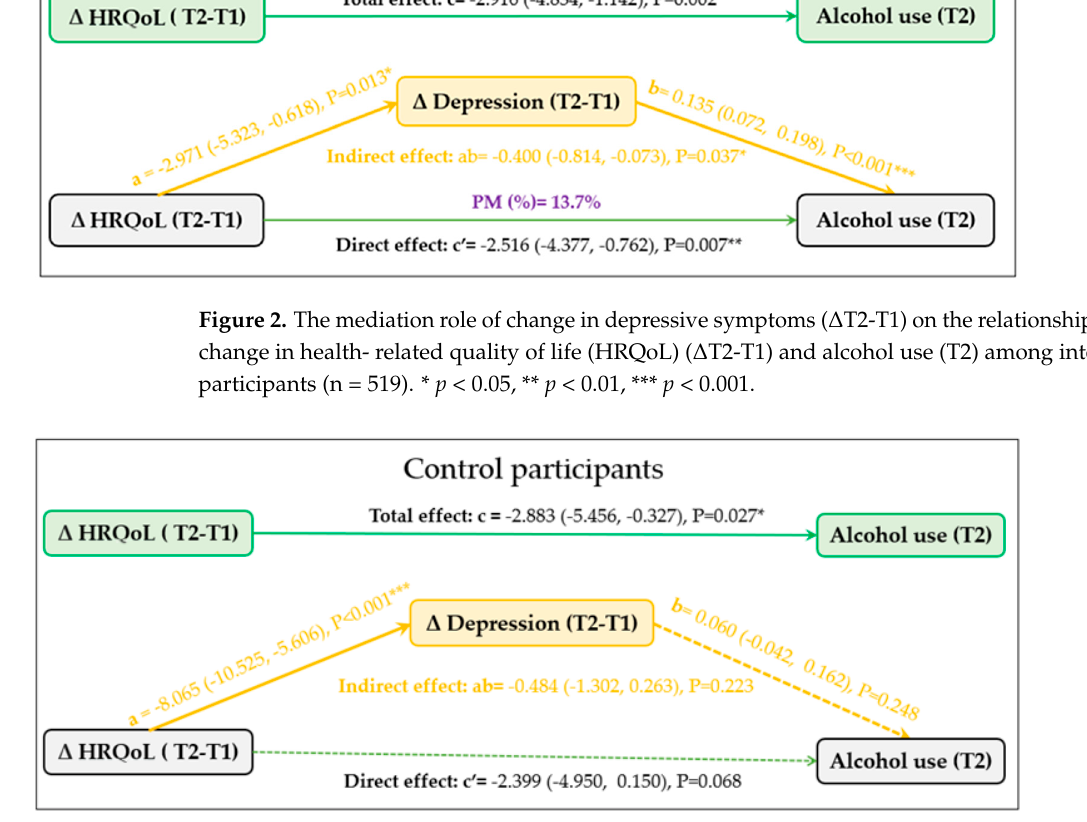
Figure 3. The mediation role of change in depressive symptoms ( ∆ T2-T1) on the relationship between change in health- related quality of life (HRQoL) ( ∆ T2-T1) and alcohol use (T2) among control participants (n = 352). * p < 0.05, *** p <